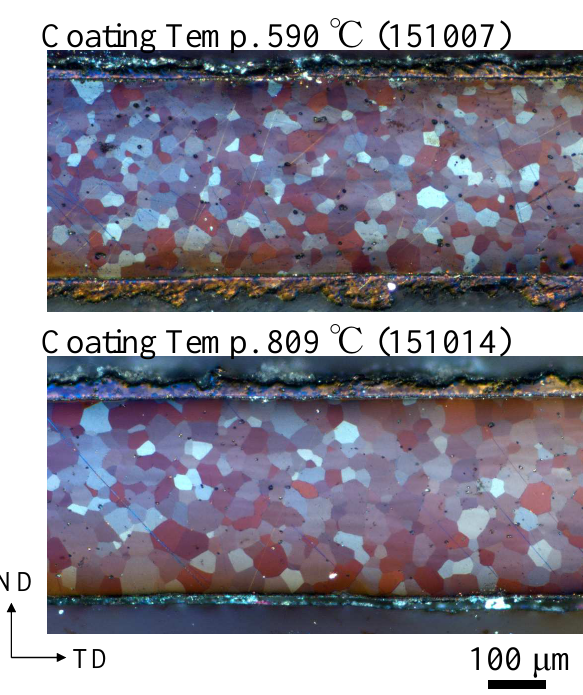
Figure 4. Optical micrographs of 2 Zr-coatedsamples: 151007 and 151014 coated at the lowest (T = 590 ◦ C) and highest (T = 809 ◦ C) temperature,